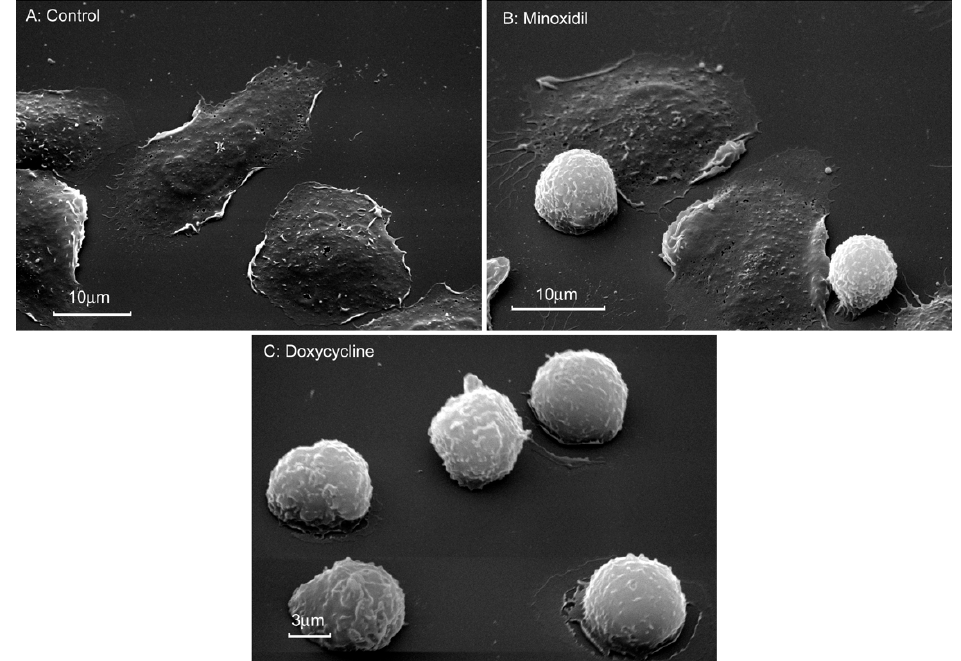
Figure 3. Morphology of neutrophils that were attached to fibronectin in the presence of minoxidil and doxycycline. Scanning electron microscopy images of human neutrophils that were attached to fibronectin-coated substrata for 20 min under control conditions ( A ) or in the presence of 200 µ M minoxidil ( B ) or 20 µ M doxycycline ( C ). Pictures represent typical images observed in three independent